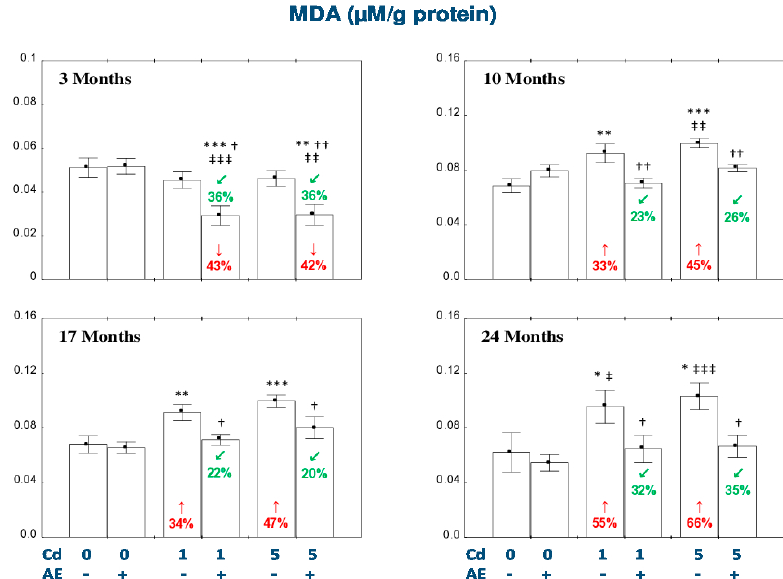
Figure 6. The effect of the extract from the berries of Aronia melanocarpa L. (AE) on the concentration of malondialdehyde (MDA) in the liver of rats exposed to cadmium (Cd). The rats received Cd in the diet at the concentration of 0, 1, and 5 mg Cd/kg and/or 0.1% aqueous AE (+) or not (-). Data are presented as mean ± SE for eight rats, except for seven animals in the AE, Cd 1 , and Cd 5 group after 24 months. Statistically significant differences (ANOVA, Duncan’s multiple range test): * p < 0.05, ** p < 0.01, *** p < 0.001 vs. control group; † p < 0.05, †† p < 0.01 vs. respective group intoxicated with Cd alone; ‡ p < 0.05, ‡‡ p < 0.01, ‡‡‡ p < 0.001 vs. group receiving AE alone. Numerical values in bars or above the bars disclose the percentage changes in comparison to the control group ( ↓ , decrease; ↑ , increase) or the respective group receiving Cd alone ( ↙ , decrease).